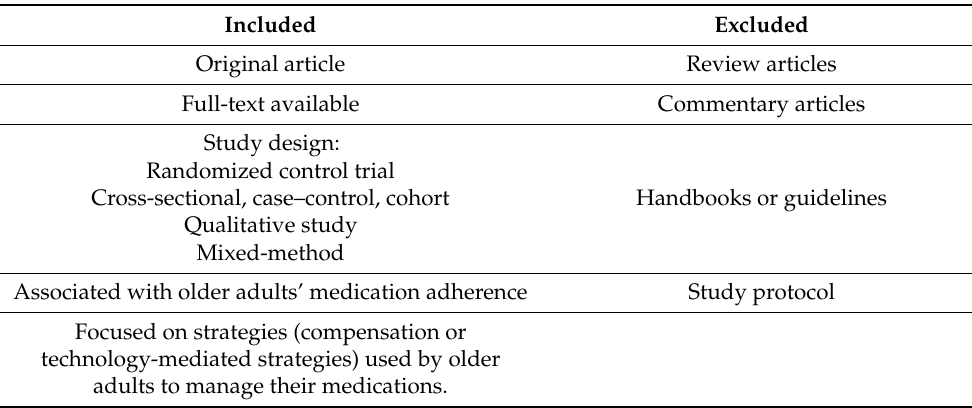
Table 1. Inclusion and Exclusion